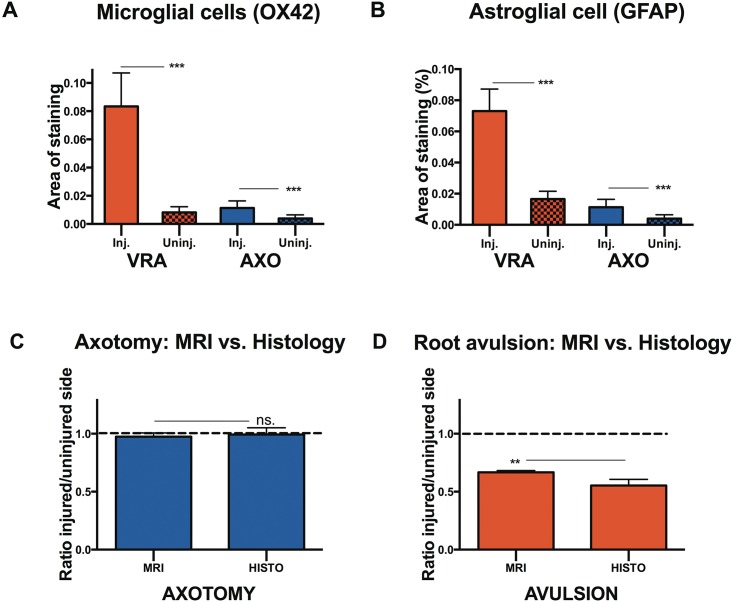
Quantification of the glial response and assessment of correlation between MRI and histological data.Histogram showing the relative tissue area occupied by OX42-positive microglial cells (A) and and GFAP-positive astroglial (B) in the L4-L5 segments of the spinal cord 4 weeks after ventral root avulsion (VRA) or axotomy (AXO) on the injured (Inj.) and uninjured side (Uninj.). Histogram showing the comparison between the relative area ratio following axotomy (C) and ventral root avulsion (D), as measured on MRI images (MRI) and histological preprations stained with NeuN (HISTO). Error bars show S.E.M. p<0.01 is indicated by **, p<0.001 is indicated by *** and ns. indicates lack of statistical significance.